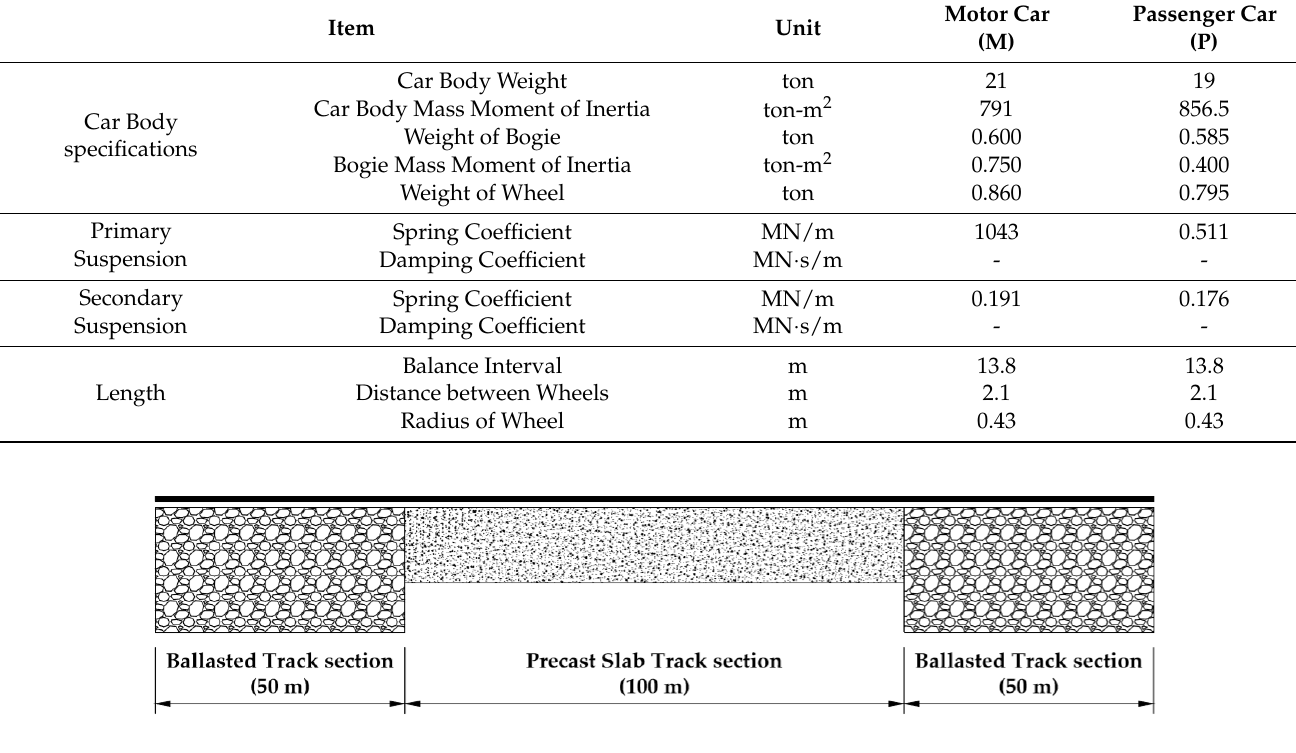
Figure 7. Track analysis sections. Table 3. Specification of track systems (half model).